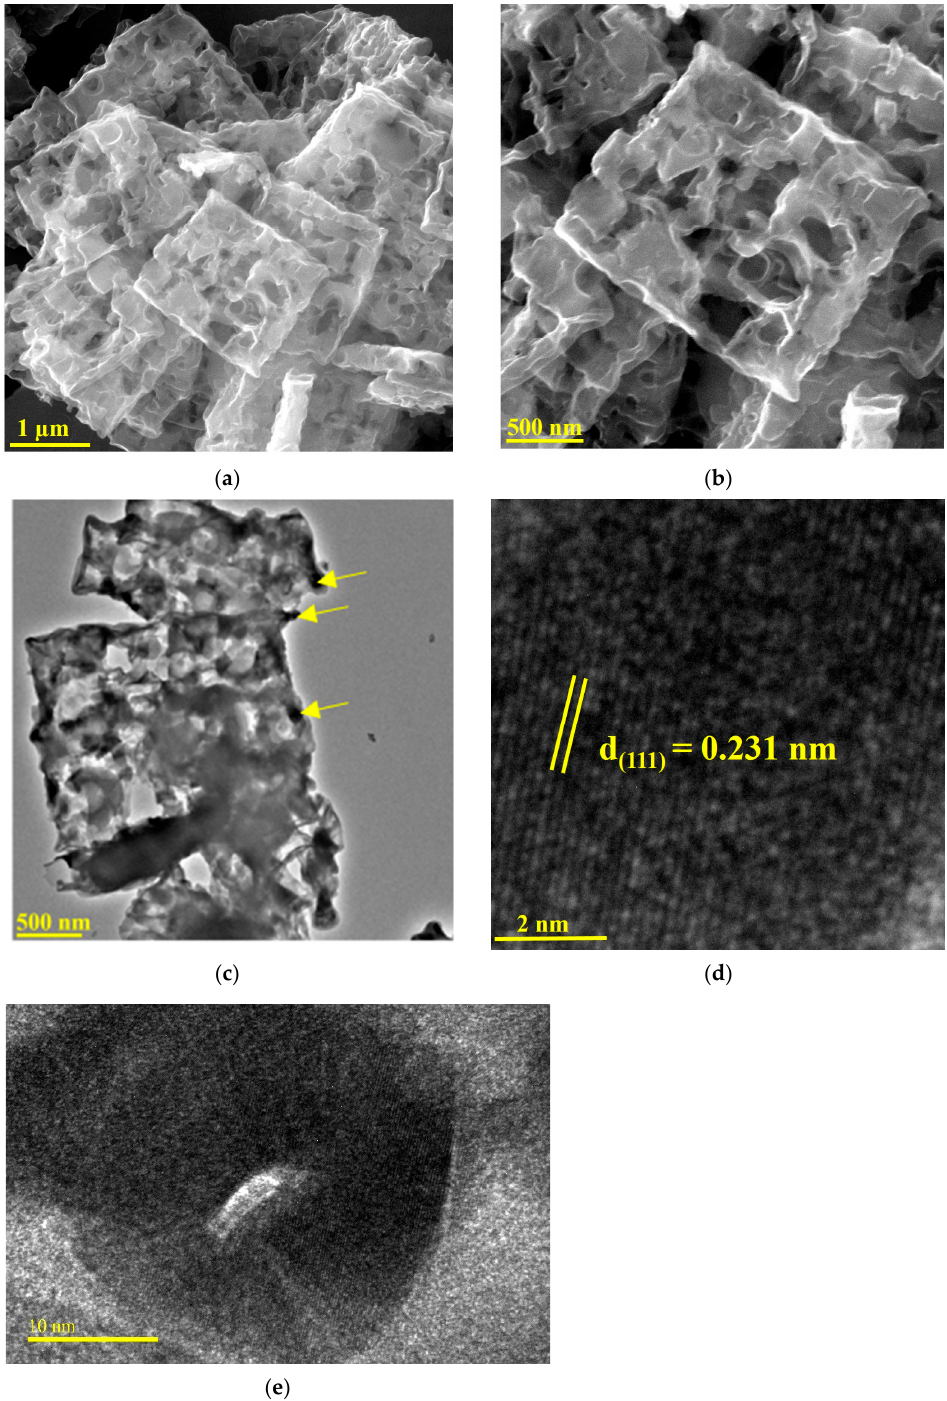
Figure 1. ( a , b ) SEM images of the unleached PCC at different magnifications, ( c ) TEM image of two overlapping cuboids, ( d ) HRTEM demonstrating lattice fringe of a copper particle, ( e ) HRTEM image of one Cu nanoparticle.